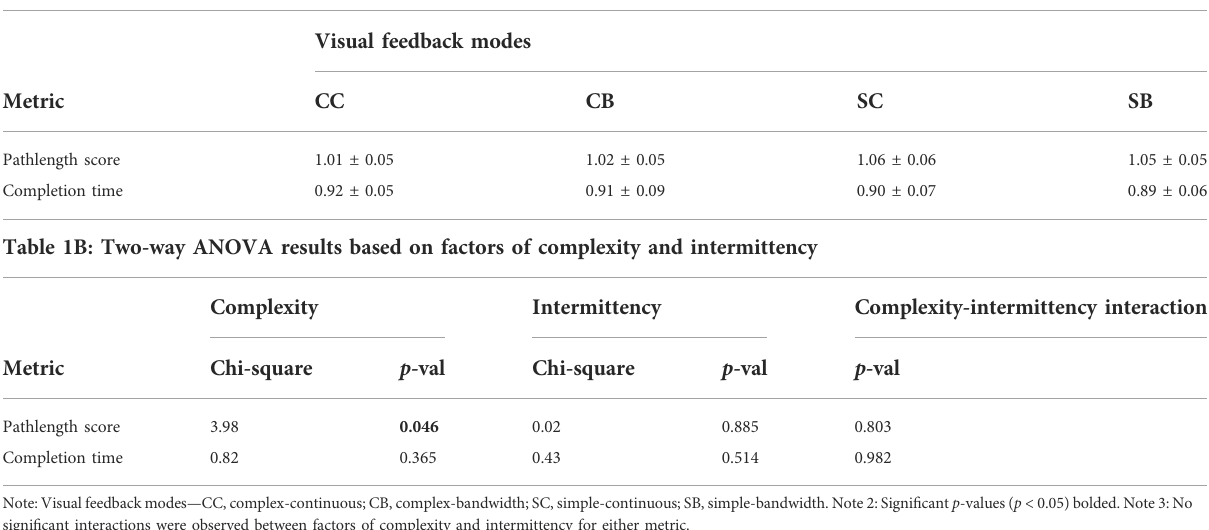
Table 1A: Mean performance across visual feedback modes